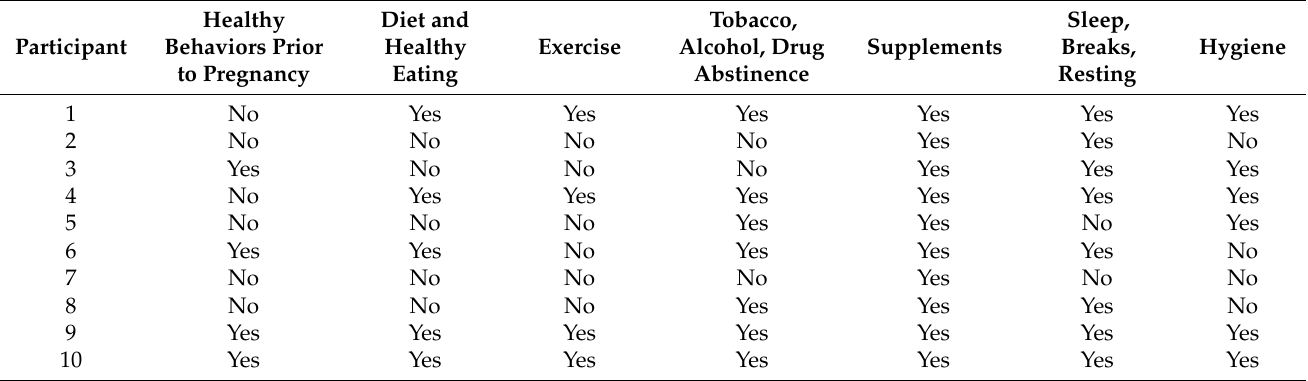
Table 3. Overview of different behavior changes during pregnancy from the ten